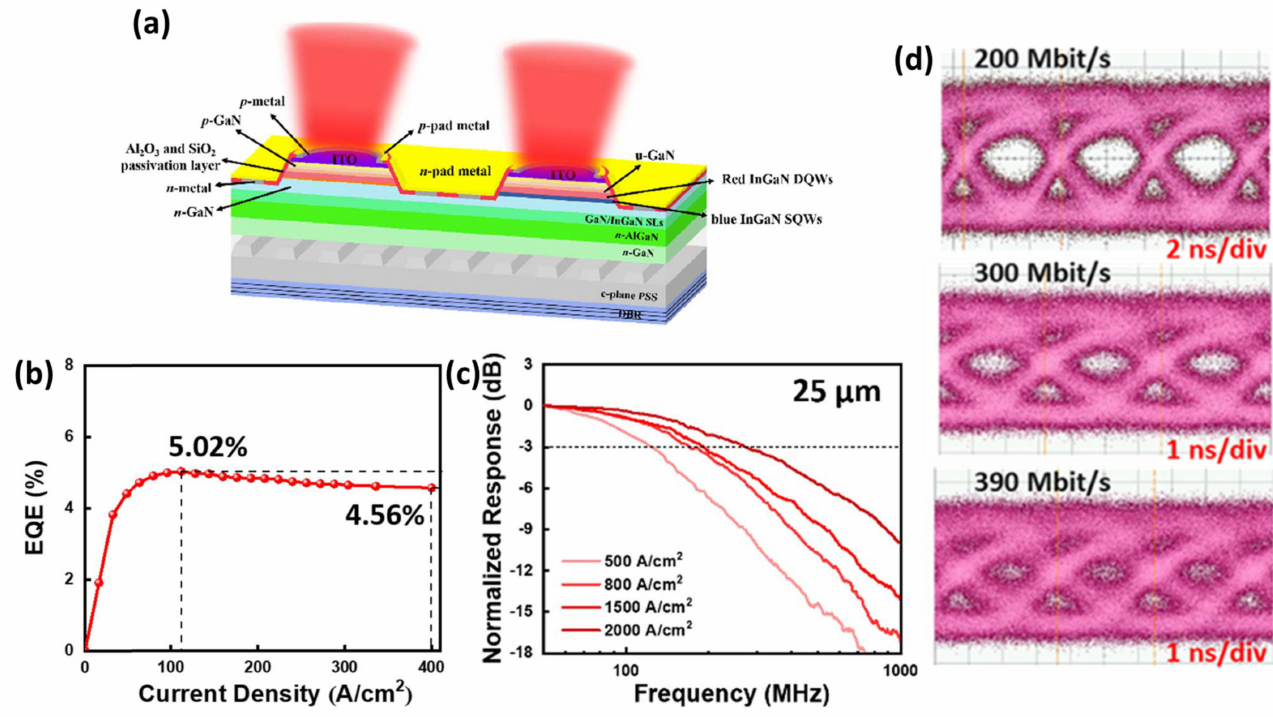
Figure 11. ( a ) Schematic diagram of c-plane InGaN red micro-LED structure. ( b ) EQE as a function of current densities for 25 µ m sized micro-LED. ( c ) Frequency response measurement of 25 µ m sized micro-LED. ( d ) Eye diagrams for 25 µ m sized micro-LED. Ref. [56] Figures reproduced with permission from Optica Publishing